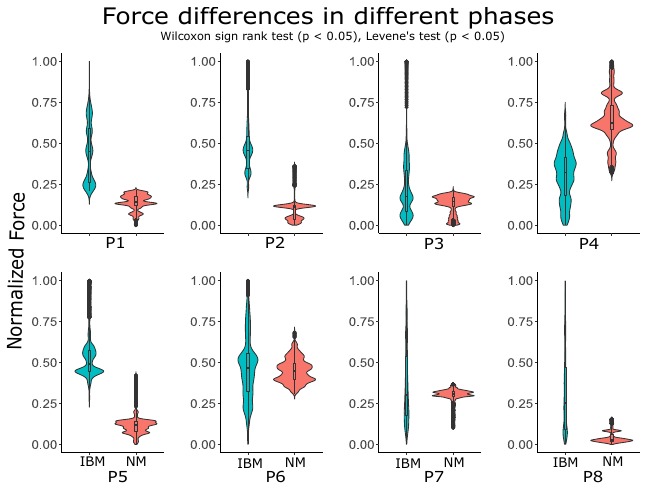
Figure 2. The top panels (labeled with participant IDs—P1, P2, P3, P4) and the bottom panels (labeled with participant IDs—P5, P6, P7, P8) show the violin plots of the respective participants. The y-axis is a normalized force value. The A box plot is also encapsulated within the violin plot. The gray region represents the high spikes (outliers) in the data, and the p values for each participant are displayed on the top of each panel. The p value describes the results for both tests as differences in median and variance were statistically significant for all